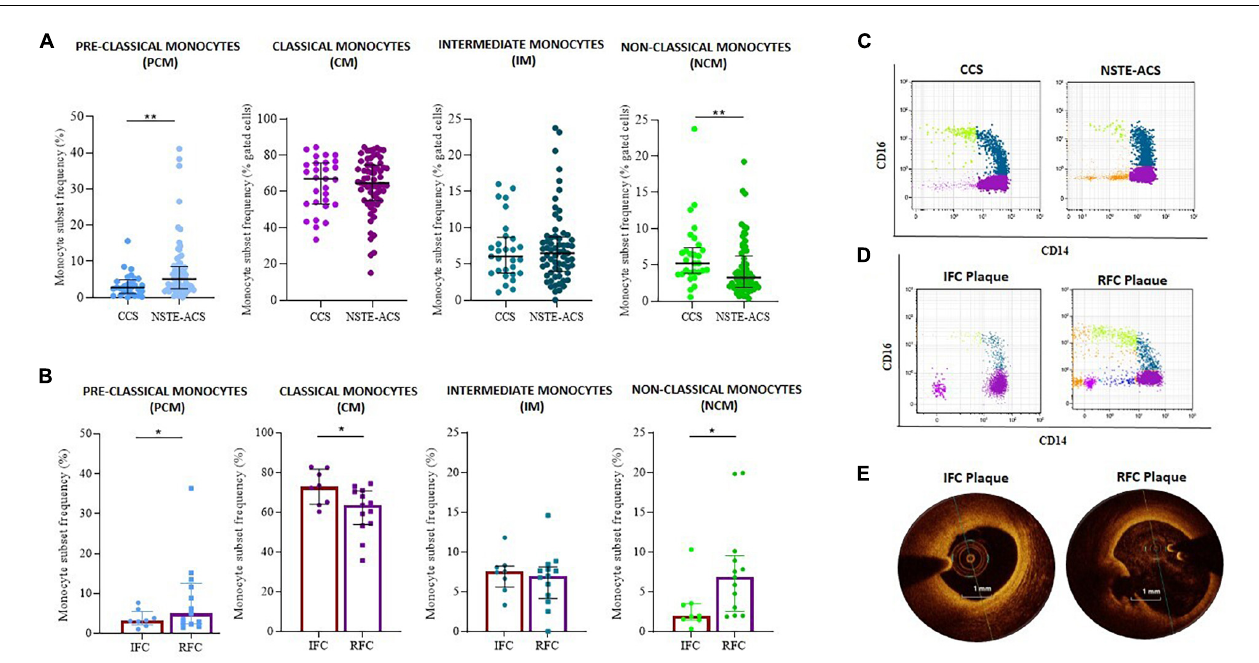
FIGURE 3 | Distribution of monocyte subsets between chronic coronary syndrome (CCS) and non-ST elevation acute coronary syndrome (NSTE-ACS) patients and its relationship with plaque phenotype at optical coherence tomography (OCT) investigation. (A) Frequency of pre-classical, classical, intermediate, and non-classical monocytes in CCS ( n = 30) and NSTE-ACS ( n = 69) patients and (B) in NSTE-ACS patients with evidence of intact fibrous cap (IFC, n = 8) and ruptured fibrous cap (RFC, n = 13) plaques according to OCT investigation. Two representative dot plots showing monocyte subset distribution (C) in CCS and NSTE-ACS patients and (D) in NSTE-ACS patients presenting with IFC and RFC plaques. (E) Two representative OCT images of IFC and RFC plaques. Data are presented as mean ± SD; * p < 0.05, ** p <